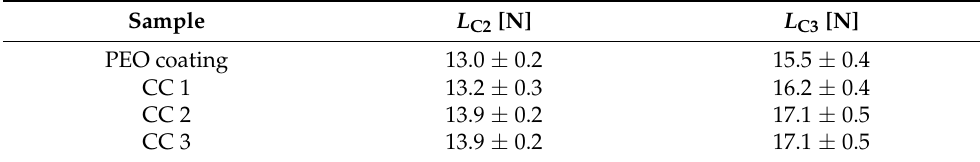
Table 4. Critical loads for coatings obtained on AMg3 aluminum alloy.